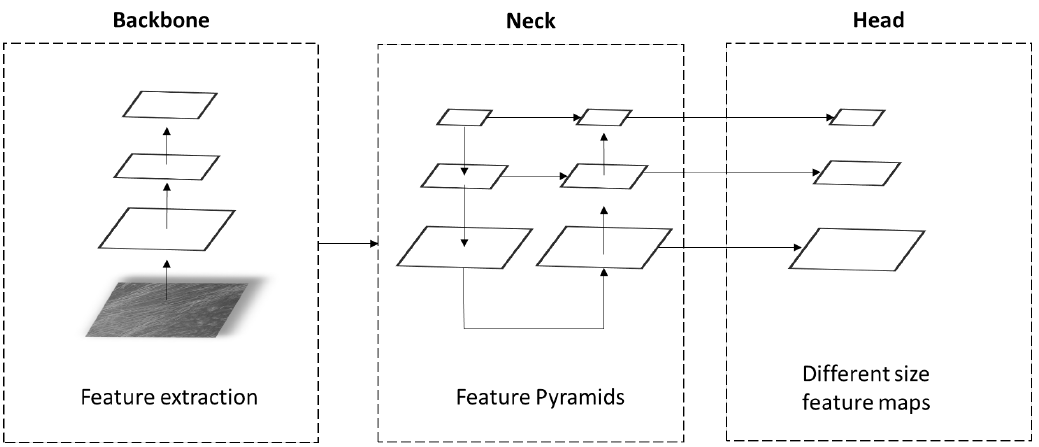
Figure 15. YOLOv5